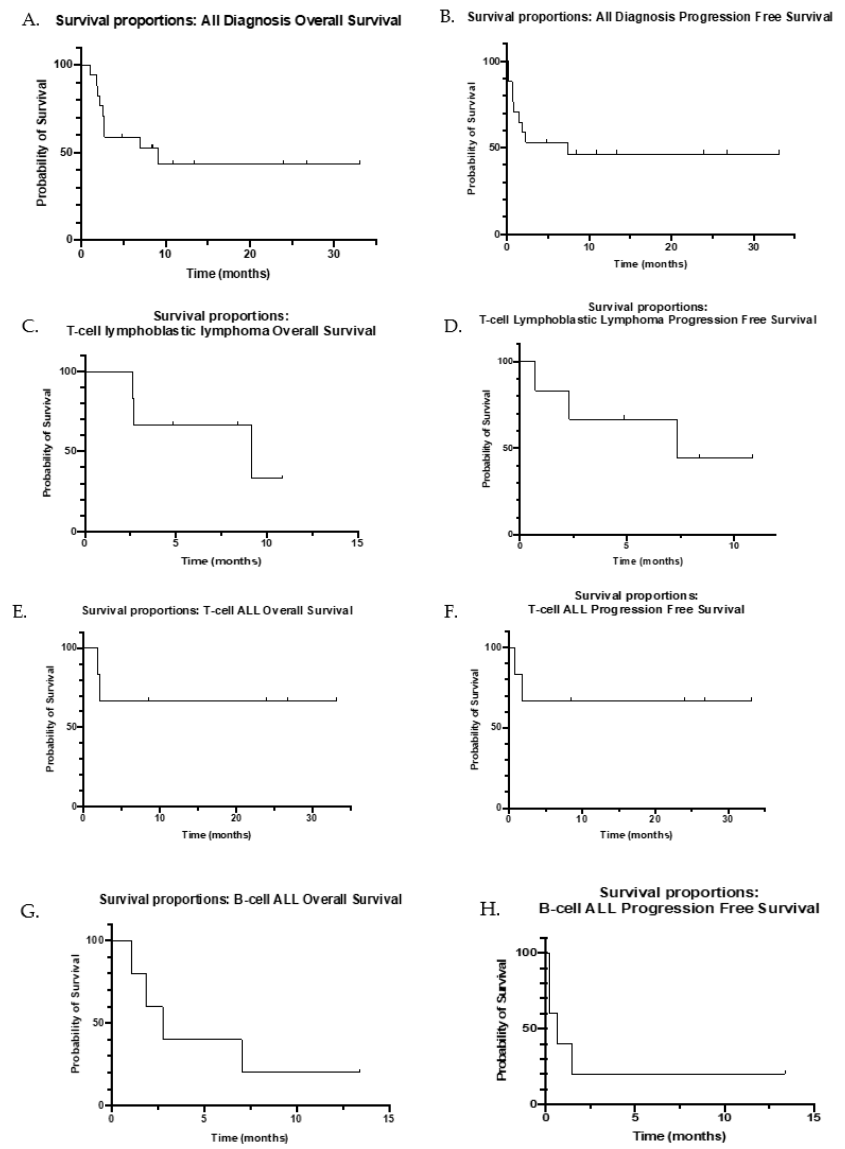
Figure 1 . Kaplan–Meier curves for overall survival and progression-free survival. Survival propor- tions graphs from the start of venetoclax therapy to a major event, defined as progression or death. ( A ) Overall survival (OS) for all disease diagnoses. ( B ) Progression-free survival (PFS) for all disease diagnoses. ( C ) OS for T-cell LBL patients. ( D ) PFS for T-cell LBL patients. ( E ) OS for T-cell ALL patients. ( F ) PFS for T-cell ALL patients. ( G ) OS for B-cell ALL patients. ( H ) PFS for B-cell ALL patients.